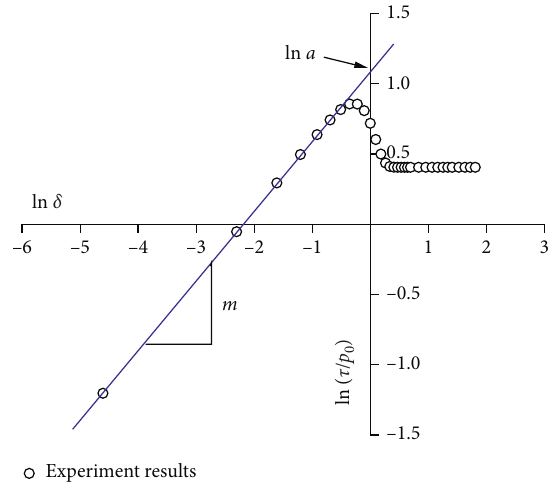
Figure 6: ln ( τ/p